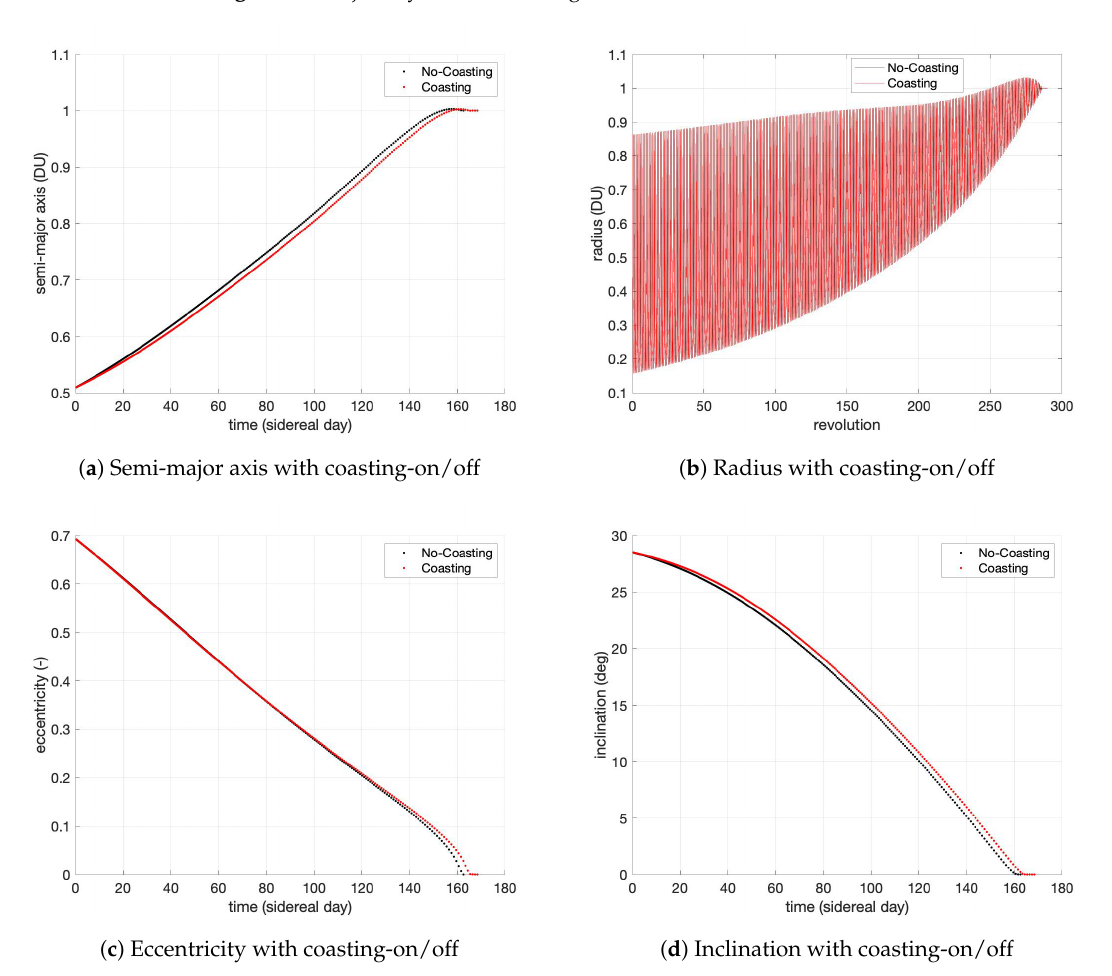
Figure 10. Trajectory and control angles of Sub-GTO to GEO transfer.